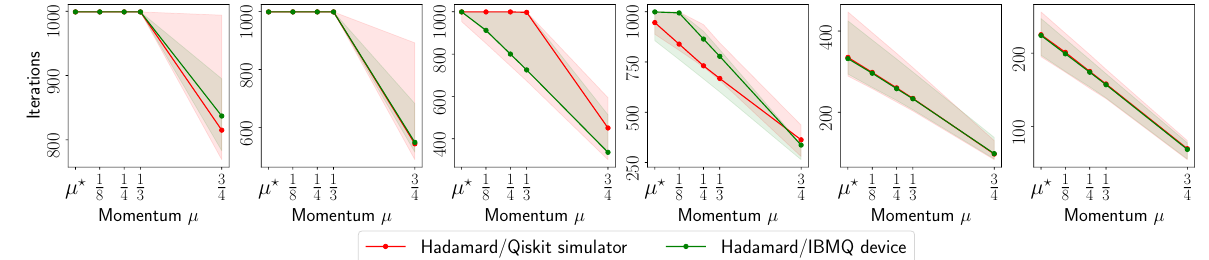
Figure A15. Convergence iteration plots for reconstructing Hadamard ( 6 ) circuit using using real mea- surements from IBM Quantum system experiments and synthetic measurements from Qiskit simulation.